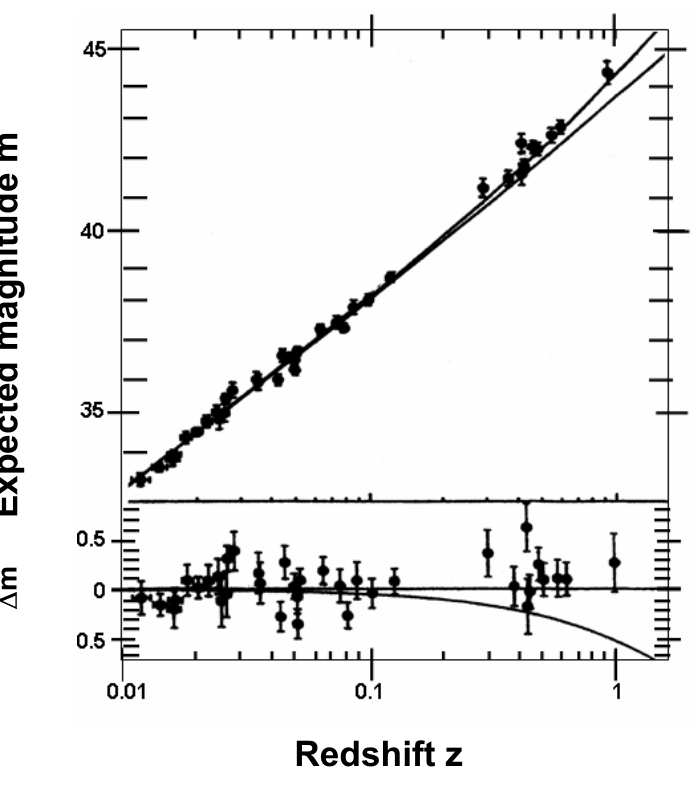
Fig. 1 – The present situation with Ia supernovae: Effective magnitude as a function of redshift [10] The lower curve is without deceleration. The best fit (upper curve) implies vacuum